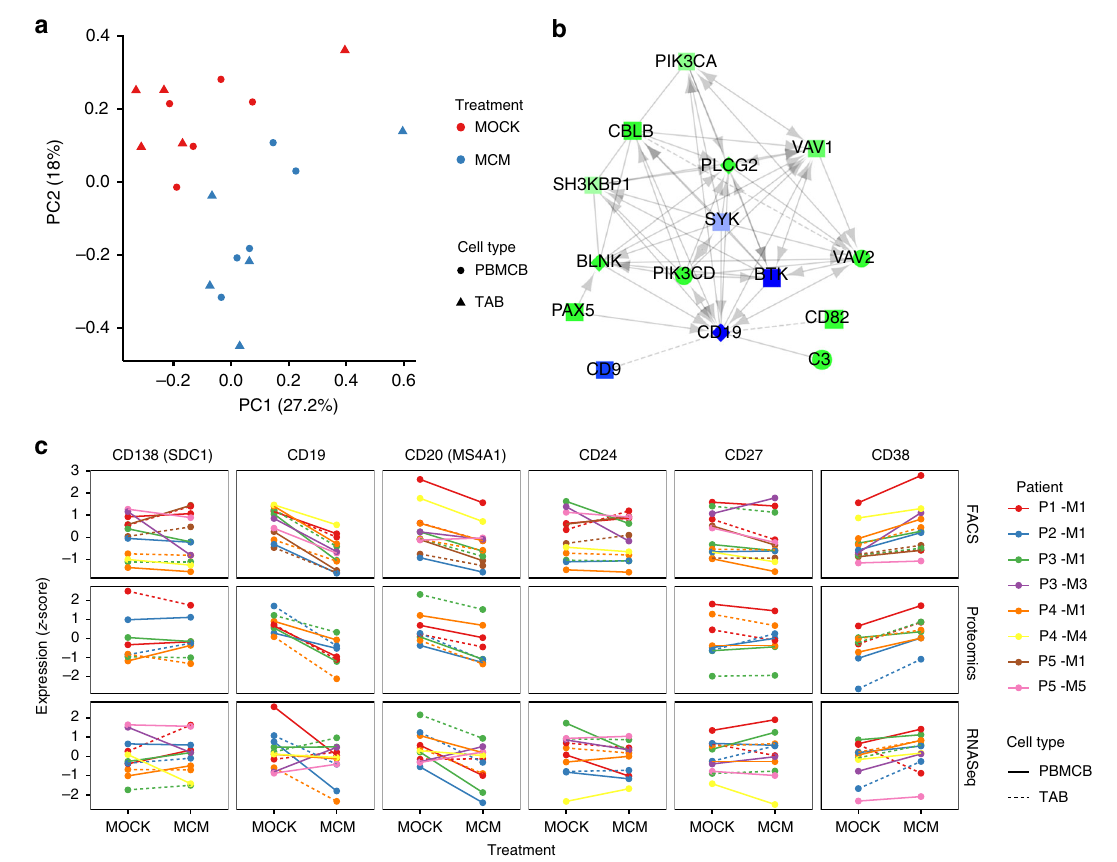
Fig. 2 Melanoma secretomes induce distinct phenotypic changes in TAB. a Principal component analysis of all samples based on the proteomics data comparing samples treated with melanoma-conditioned medium (MCM, blue) against control treated ones (MOCK, red). Peripheral-blood-derived B cells (PBMCB, circles) and TAB (triangles) are shown separately. The percentage in the axis labels represents the variation explained by the component. Points represent one sample per patient and one sample where individual patient samples were pooled together. b Interaction network of CD19 with the nearest neighbors depicting the gene abundance estimated by RNA-seq and proteomics. Green represents upregulation, blue downregulation, light colors indicate no relevant difference. Diamonds are genes only detected in proteomics, rectangles genes only detected in RNA-seq, circles genes identi fi ed by both methods. For the actual data analysis, the network was constructed using the two nearest neighbors. c Expression of key differentiation markers estimated by FACS (geo mean fl uoresence-based expression), proteomics, and RNA-seq for melanoma-conditioned medium (MCM) and control (MOCK) treated immortalized peripheral-blood-derived B cells (PBMCB, solid lines) and TAB (dashed lines). All values are shown as z NF- κ B activation. Therefore, melanoma-derived soluble factors directly induce a signaling pattern in B cells associated with activation in in fl ammation and immune response.